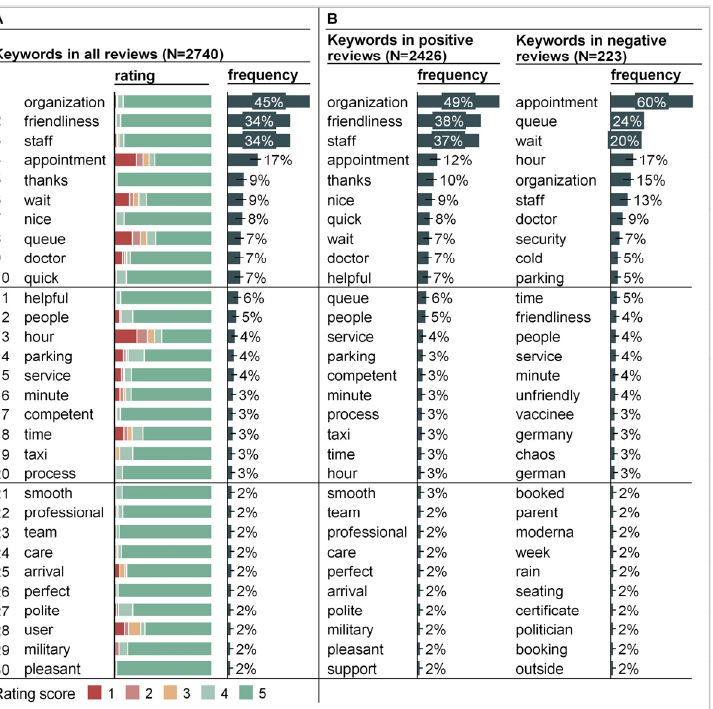
Figure 4. Top 30 keywords identified through keyword extraction. ( A ) Top 30 keywords featured across all reviews (N = 2740), sorted by frequency. ( B ) Top 30 keywords featured in positive reviews (four- or five-star rating, N = 2426) and negative reviews (one- or two-star rating, N = 223), sorted by frequency.